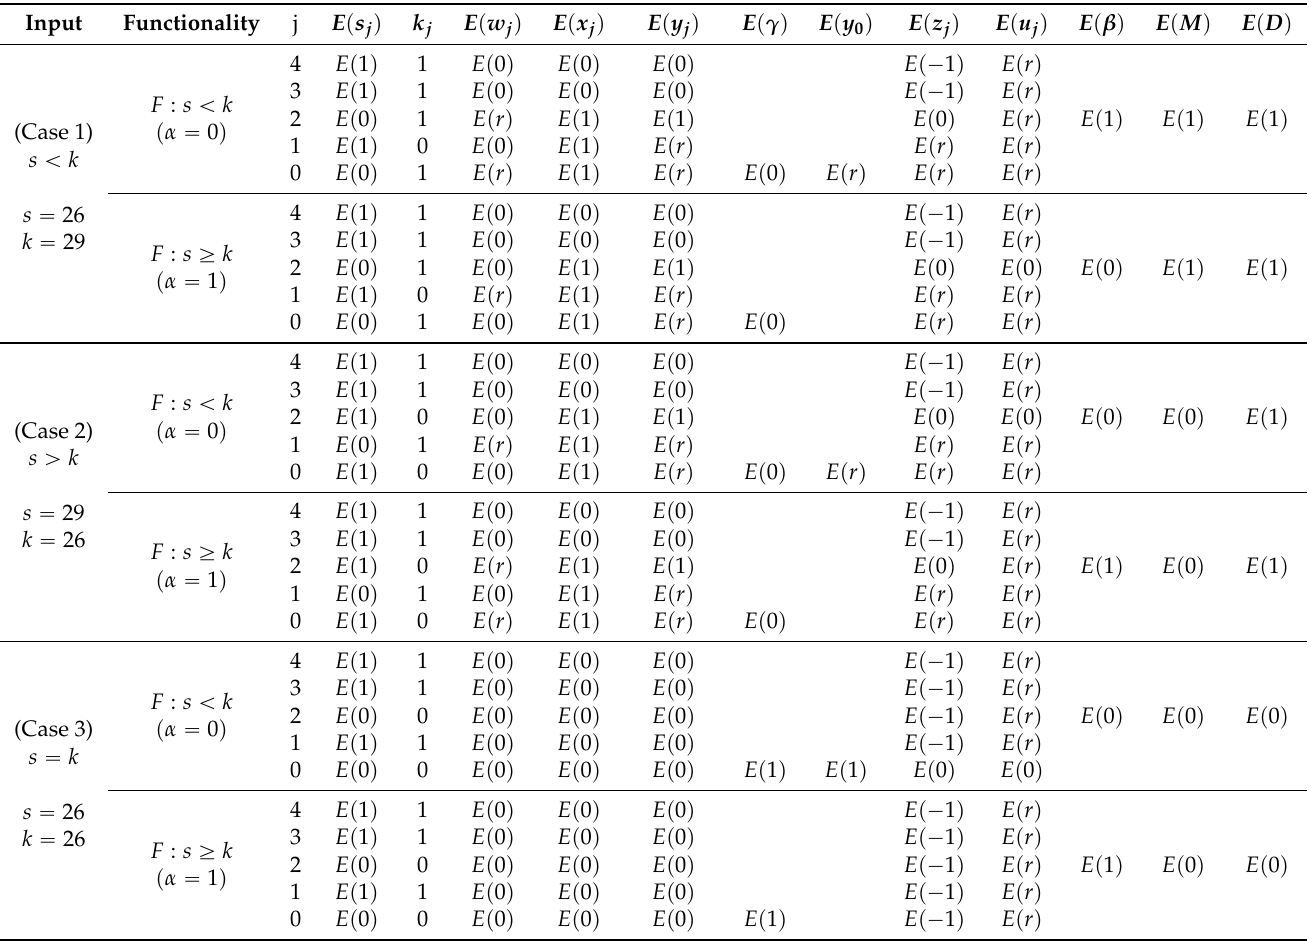
Table 2. Example of Algorithm 1 for SCI protocol ( l “